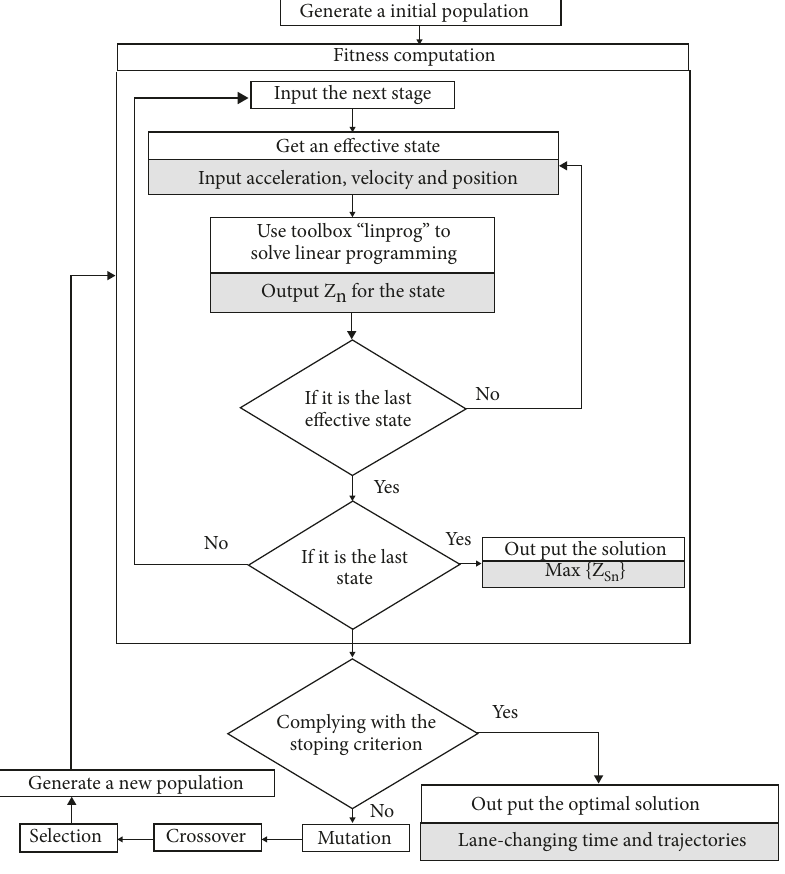
Figure 3: Computational